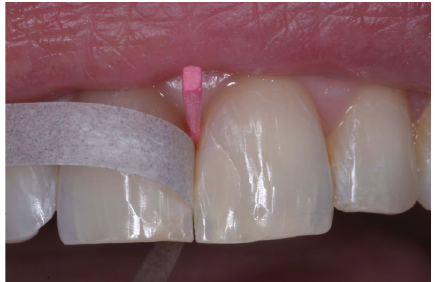
Figure 6: Interproximal preparation using finishing